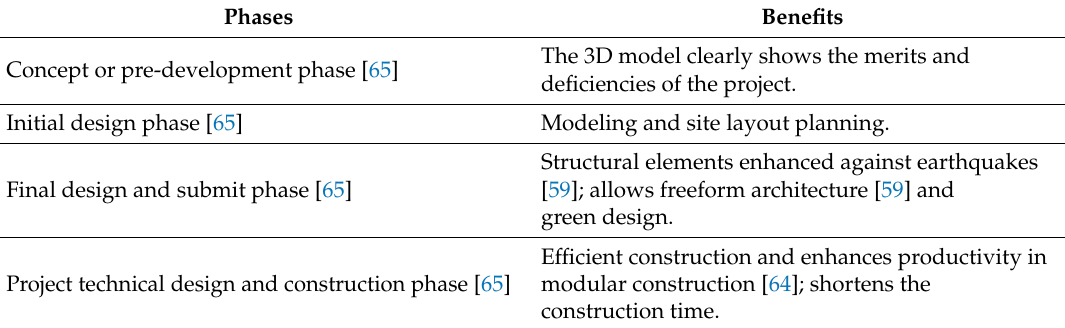
Table 9. The advantages of 3DP in the di ff erent construction